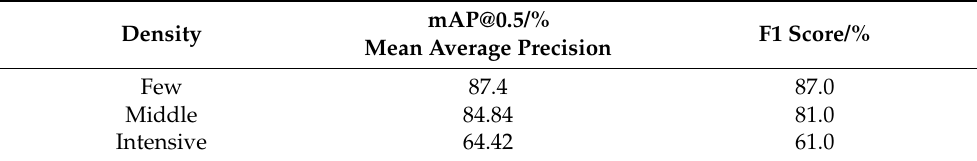
Table 3. Test results under different citrus flower